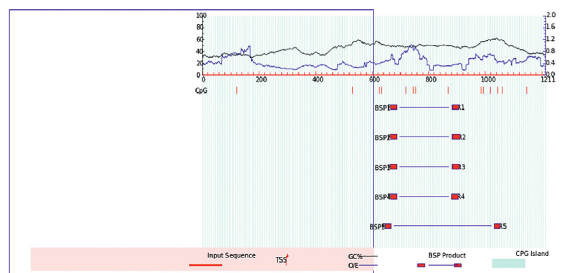
Figure 2: CpG island prediction using MethPrimer S-2: allelic and genotypic frequency of identified polymor- phisms. Figure S-1: the CpG island prediction in exonic and intronic regions of TPN1 gene. ( Supplementary Materials )